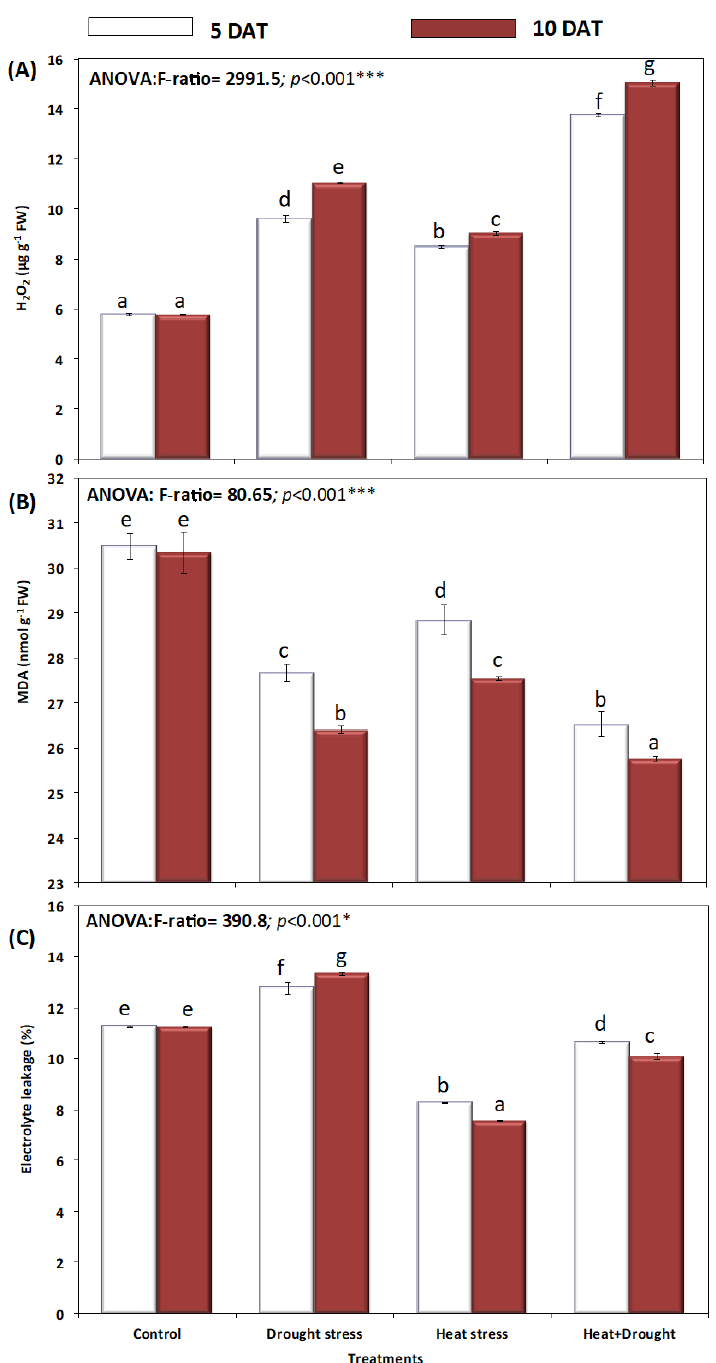
Figure 8. Effect of drought, heat, and interaction between drought and heat stresses on oxidative damage ( A ) cellular hydrogen peroxide level (H 2 O 2 ), ( B ) lipid peroxidation (MDA), and ( C ) electrolyte leakage (%) (EL) of A. sieberi alba . Data expressed as mean of triplicates, error bars represent standard error for means. Means marked with different letters are significantly different according to ANOVA and DMRTs at p < 0.05.